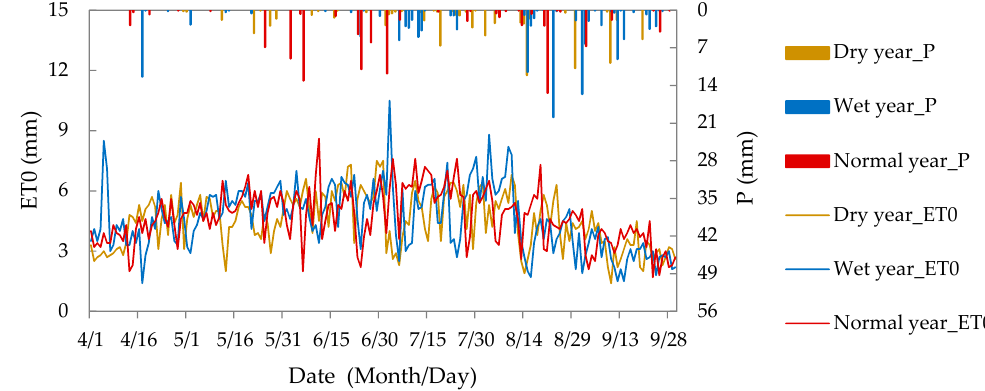
Figure 4. Reference evapotranspiration (ET0) and precipitation (P) under different climate years.